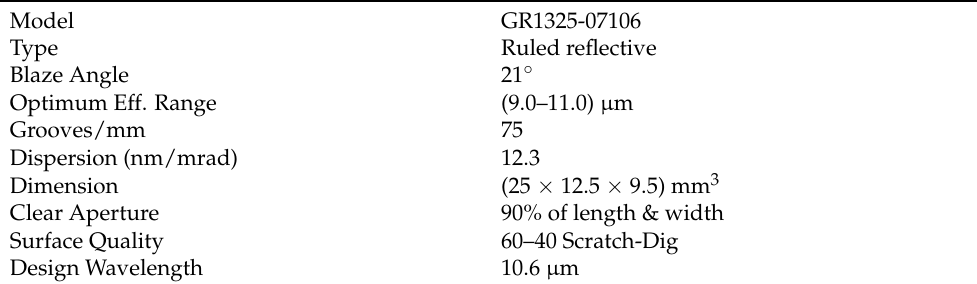
Table 6. Specifications of the mini-spectrometer’s grating.